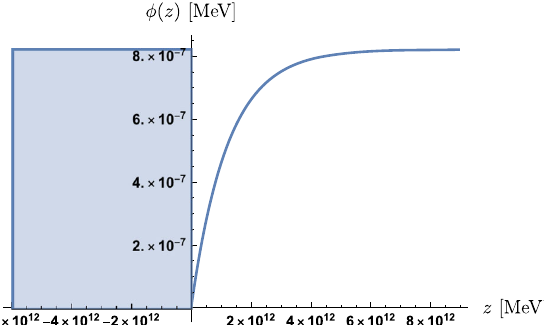
1 . 22 × 10 22 MeV is indeed satisfied in this case